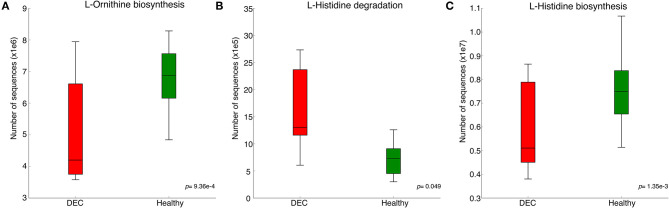
Predicted metabolic pathways related to the gut microbiota composition. Principal pathway prediction by PICRUSt2 algorithm using representative sequences of main OPUs from each group and the Greengenes database as the reference. Graphs of predictions and significance values were obtained using STAMP v. 2.1.3. Graphs represent the number of sequences in microbiota that have known genes involved in L-ornithine biosynthesis (A), L-histidine degradation (B), and L-histidine biosynthesis (C). Box plots denote the top quartile, median, and bottom quartile, analyzed using Welch's t-test.